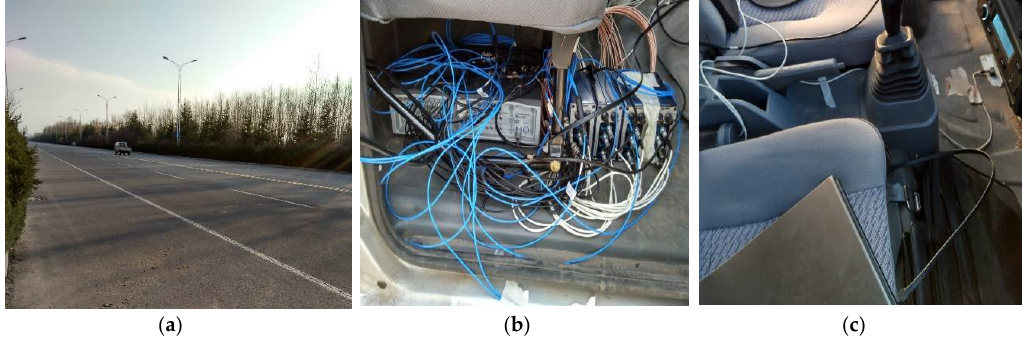
Figure 8. Road test: ( a ) the test field; ( b ) the test equipment in LMS Test.Lab; and ( c ) the set up of the test.